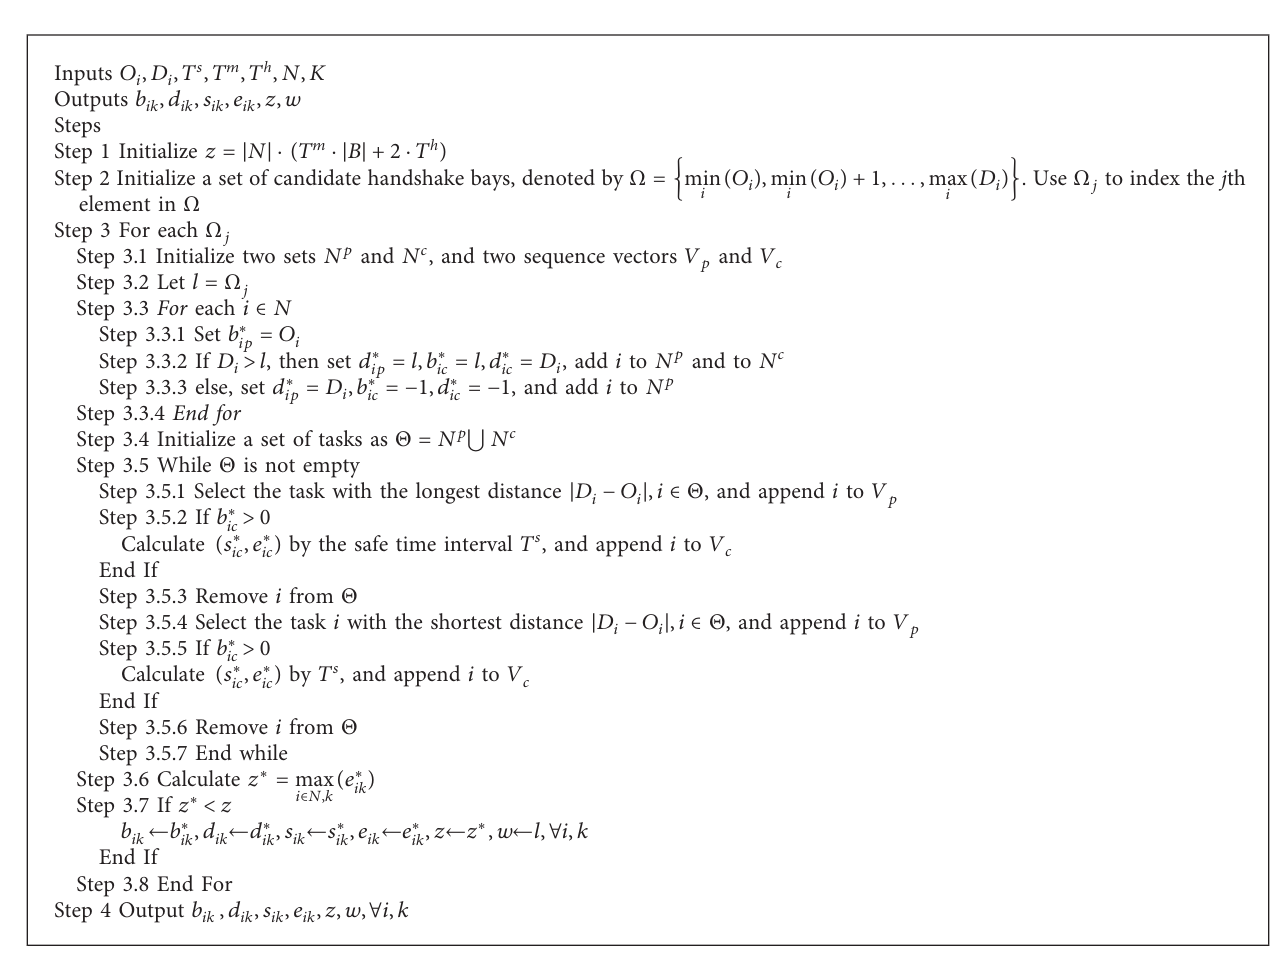
A LGORITHM 1: Greedy insert